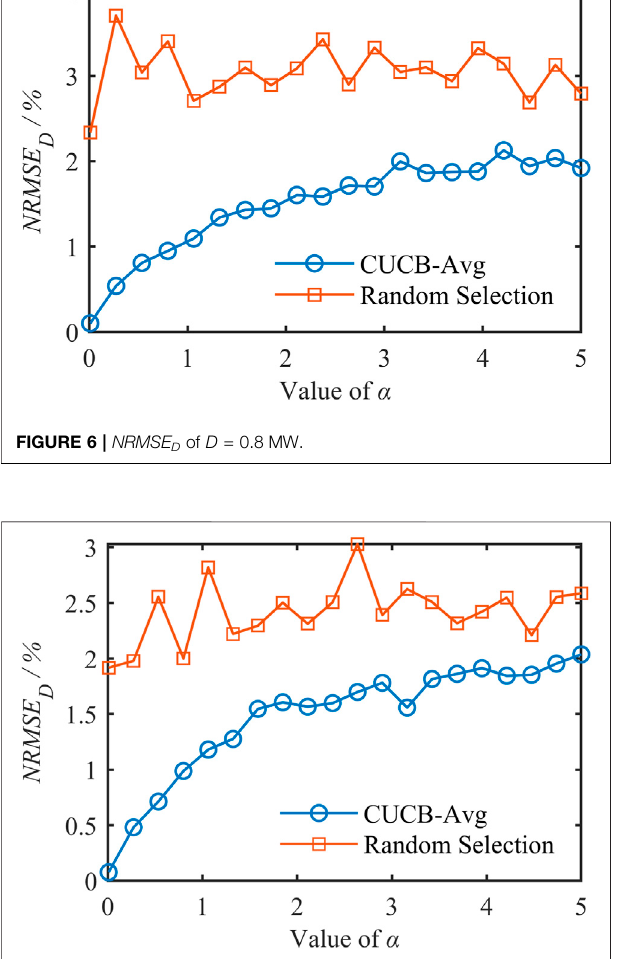
FIGURE 7 | NRMSE D of D = 1.2